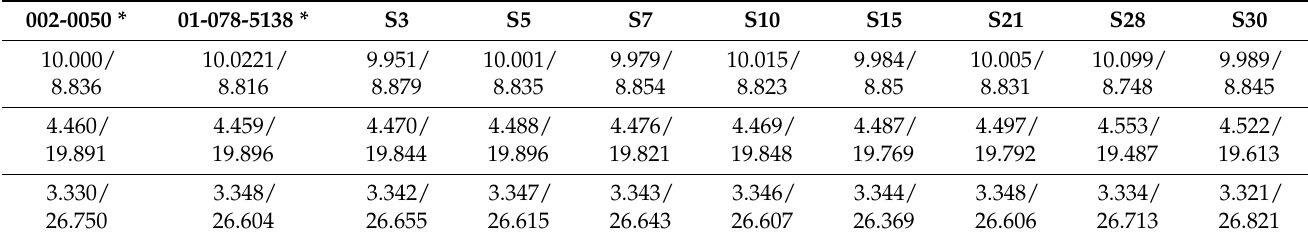
Table 2. d-spacing (Å)/ ◦ 2 θ characteristic peaks for illite according to reference materials and within M ă n ă ila bulk soil.